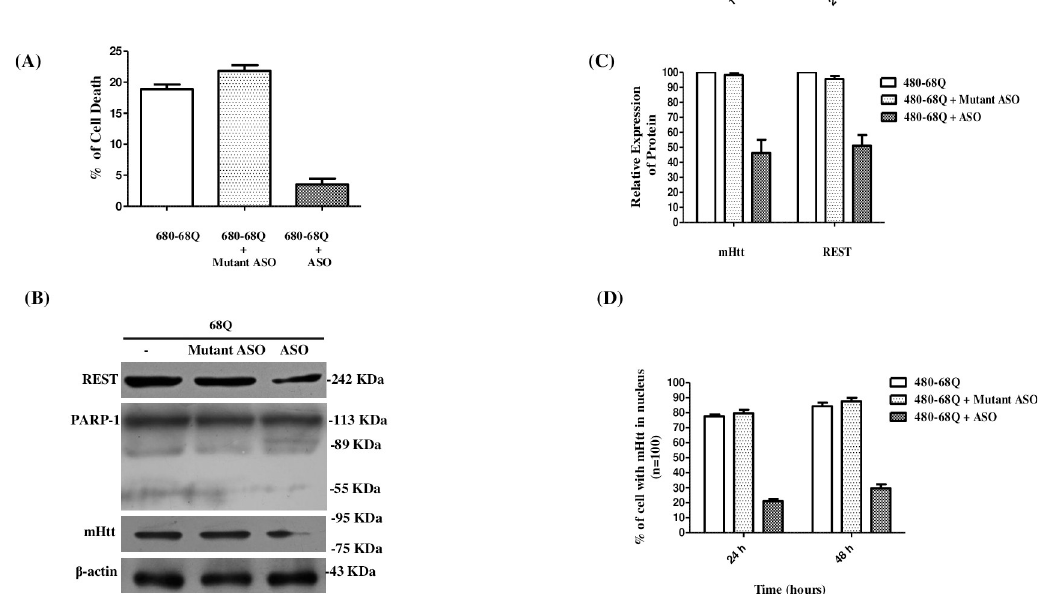
Fig 6. Inhibition of Hsp90 decreased cellular apoptosis. (A) Differentiated SH-SY5Y cells were transiently co-transfected with expression vector for GFP-68Q and 12 μ M Hsp90 ASO or 12 μ M Hsp90 mutant oligonucleotide. Their effects on cell viability were analyzed up to 48 h. Transfected cells with expression vector for GFP-480-17Q are normalized to 0% ( P < 0.05). (B) Cells lysates were analyzed by Western blotting, β -actin was used to assess total protein loading. (C) Protein levels were compared to control cells, which were only transfected with expression vector for GFP-68Q. (D) Quantitative analysis to determine the percentage of cells that presented to mHtt in nucleus. The results represent the mean and SEM (n = 100) from a series of three separate experiments ( P <